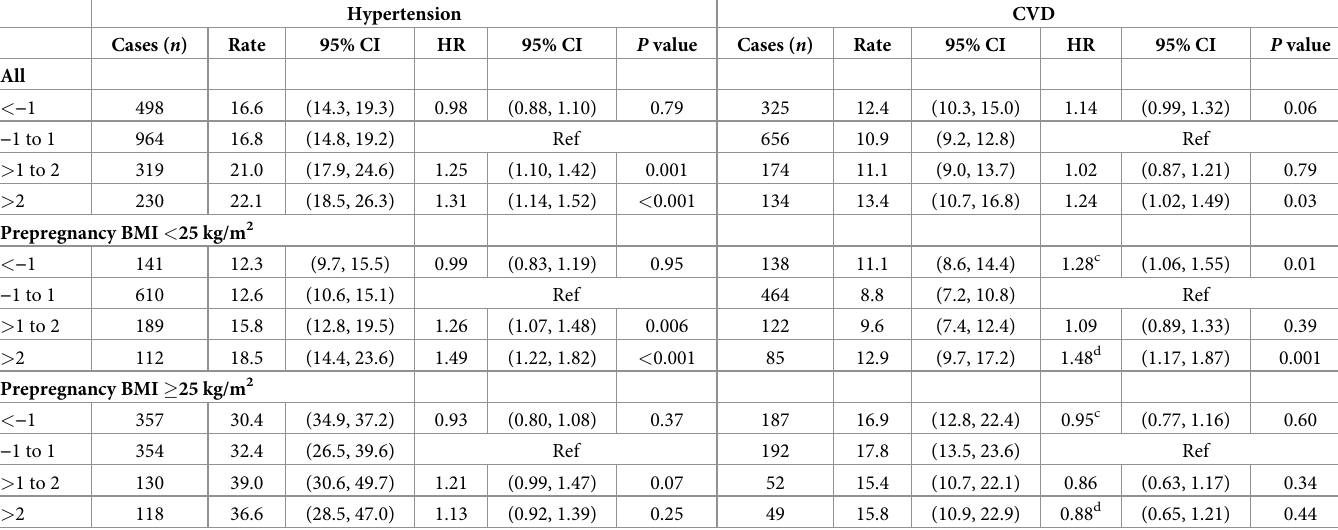
Table 2. Adjusted HRs a and rates b (95% CI) of hypertension and CVD according to weight change from prepregnancy to 18 months postpartum ( n = 47,966).